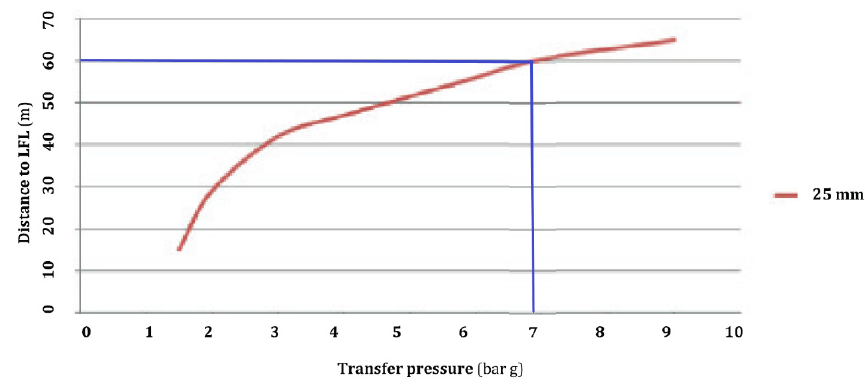
Figure 7. Distance to LFL as a function of stagnation pressure for 25 mm-diameter hole leak.